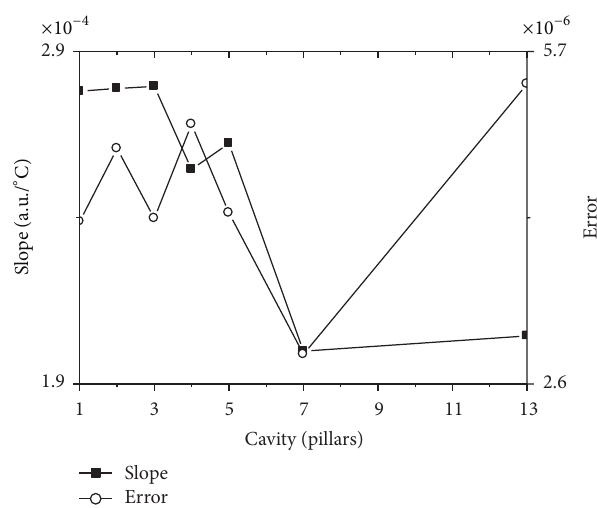
Figure 17: The slope and its error of the linear fitted curves for the resonantfrequency,whichhasthebiggestaveragenormalizedpower spectrum, change with temperature.